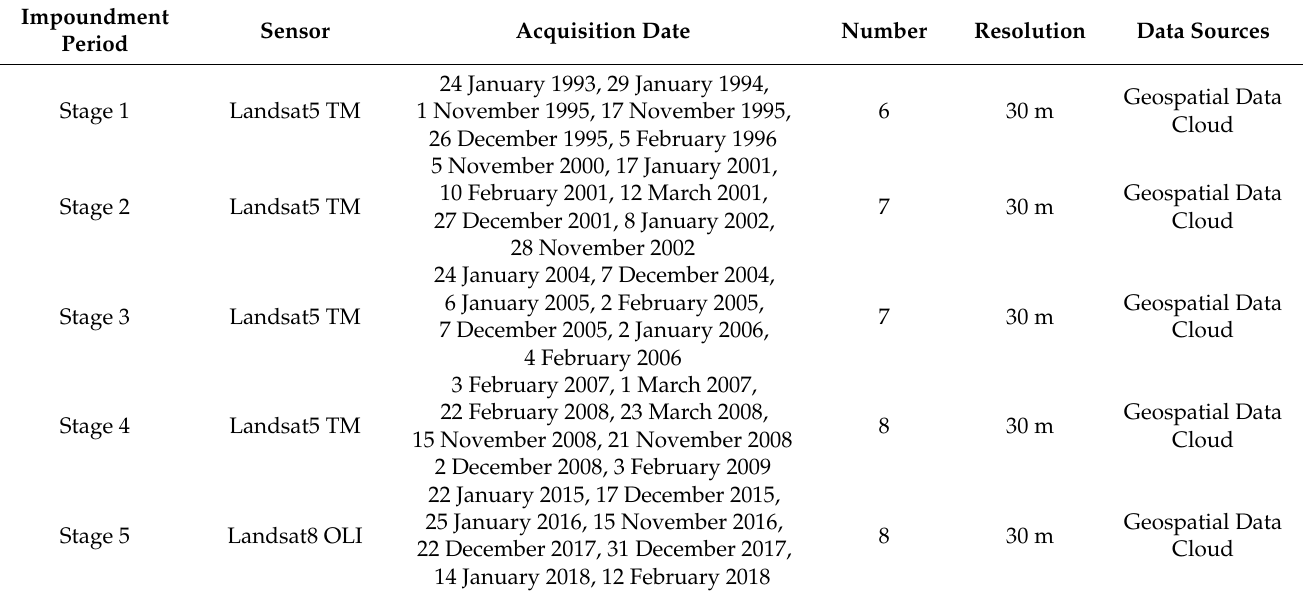
Table 1. Detailed information on the collected remote sensing